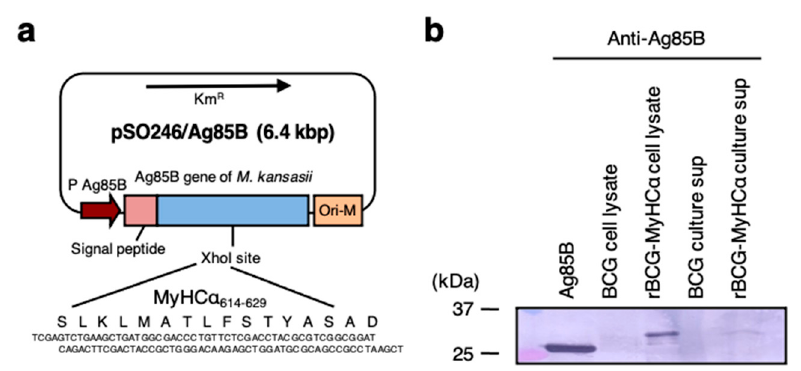
Figure 1. Construction and characterization of rBCG-MyHC α . ( a ) Oligonucleotides that encode a MyHC α CD4 epitope were cloned into an XhoI site in the coding region of the Ag85B gene from Mycobacterium kansasii cloned into pSO246 to be fused with the gene, and the plasmid was introduced into BCG by electroporation, giving rise to rBCG-MyHC α . ( b ) Western blot analysis of recombinant Ag85 protein or M. kansasii , cell lysates of BCG and rBCG-MyHC α , and culture supernatants of BCG and rBCG-MyHC α .